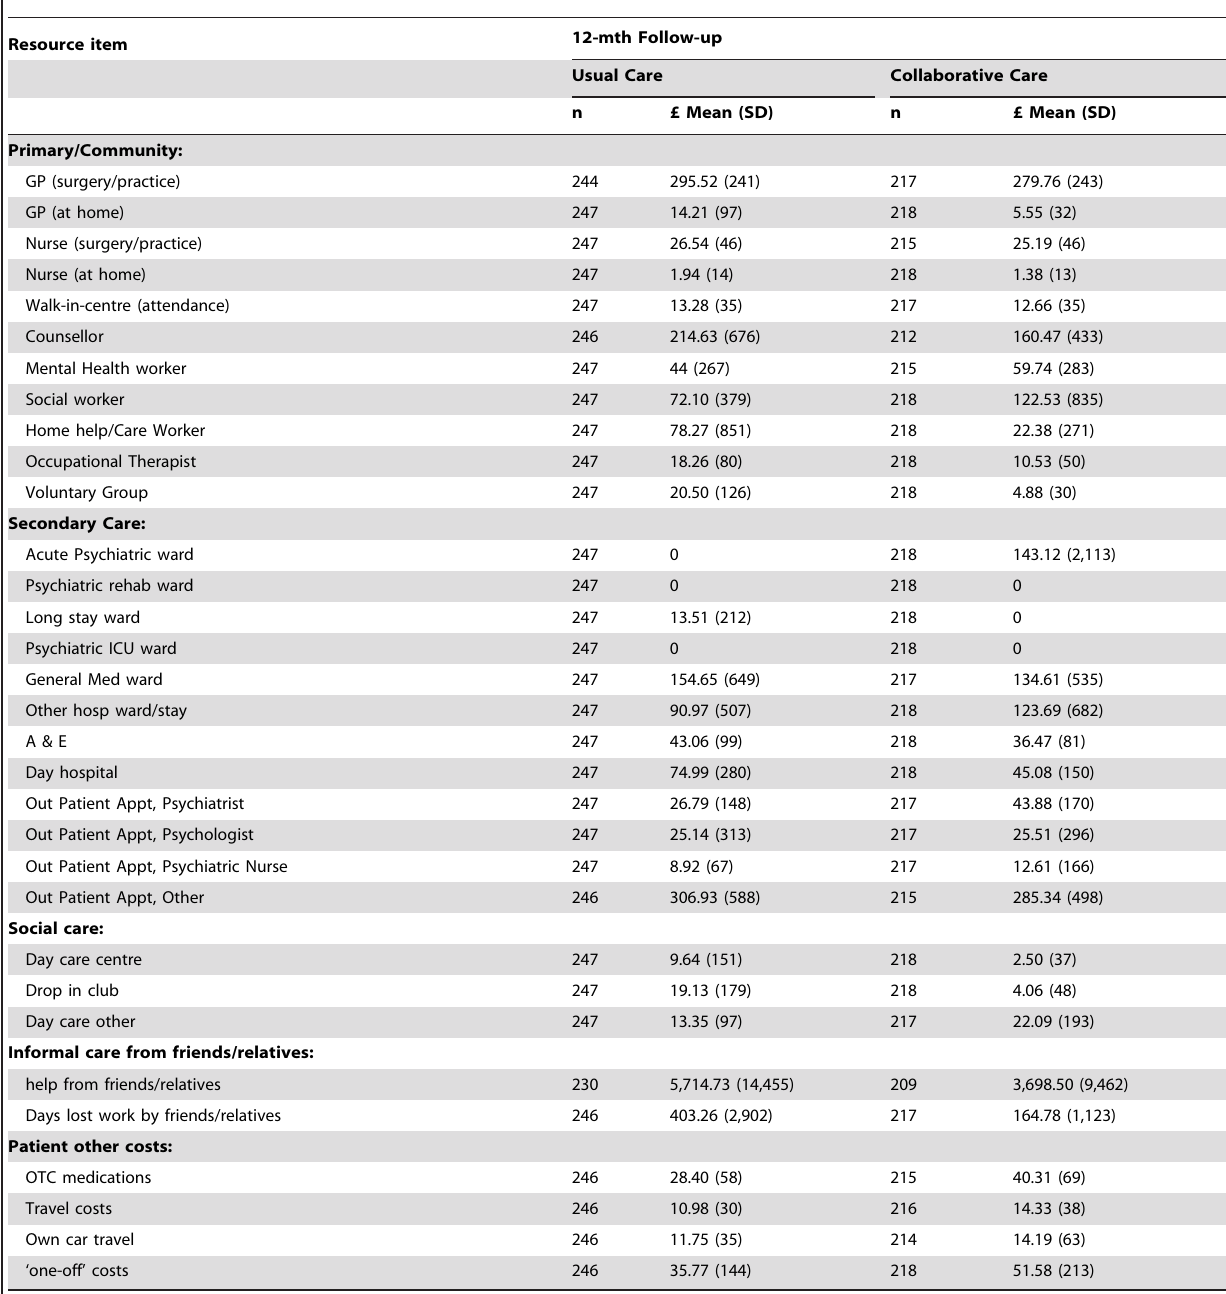
Table 3. Estimated mean cost (£’s) for health, social care, and other resource use, over 12 month follow-up.